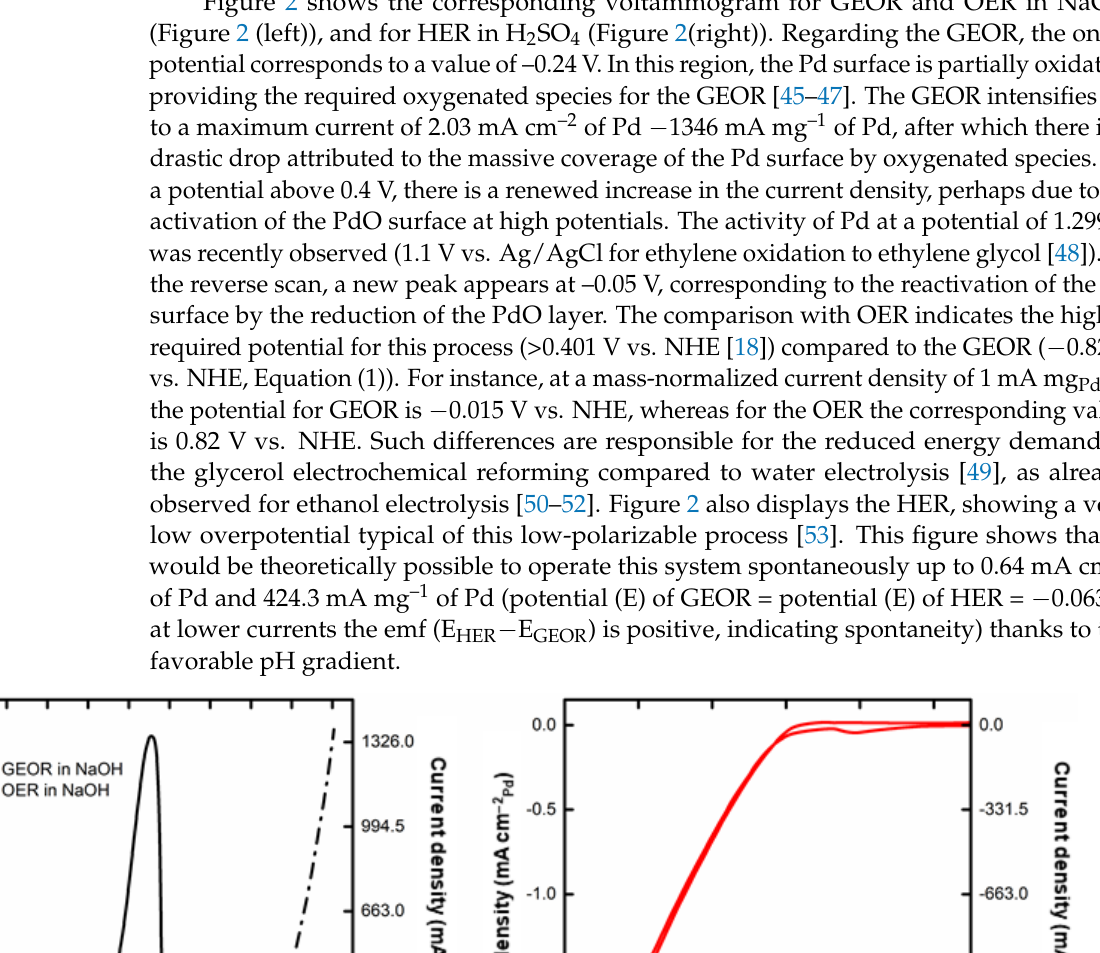
Figure 2. ( left ) CV for GEOR in 1 mol L − 1 glycerol in 1 mol L − 1 NaOH, OER in 1 mol L − 1 NaOH, and ( right ) HER in 0.5 mol L − 1 H 2 SO 4 (measurement carried out in the three-electrode glass cell).